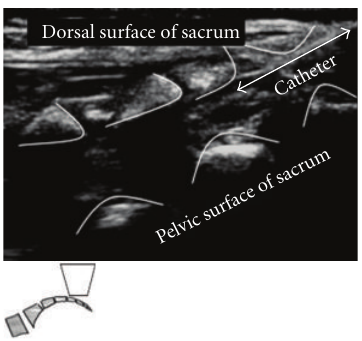
Figure 3: Caudal epidural catheter passing through Angiocatheter in the epidural space.